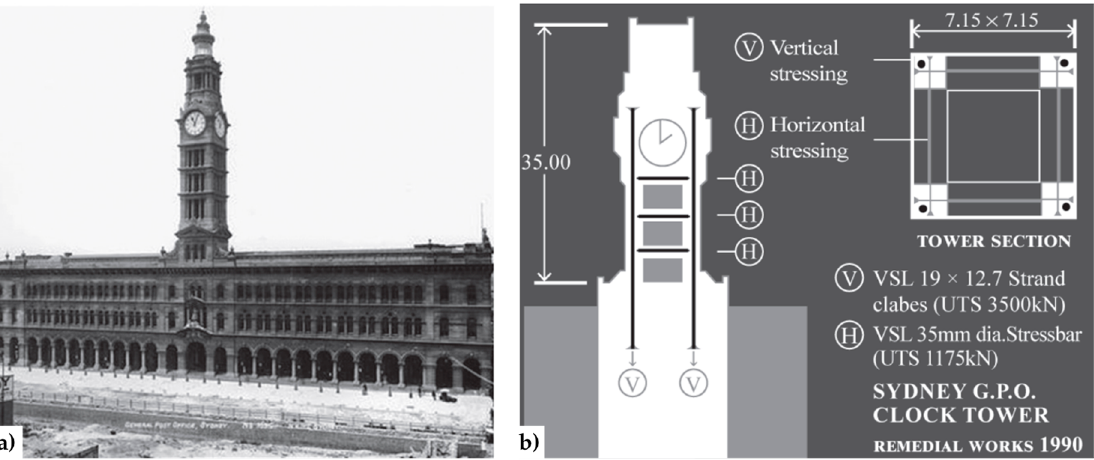
Figure 4. The General Post Office (GPO) Tower (Sydney, Australia): ( a ) external overview of the GPO façade; ( b ) strengthening scheme with the internal horizontal and vertical tie-bars [22].